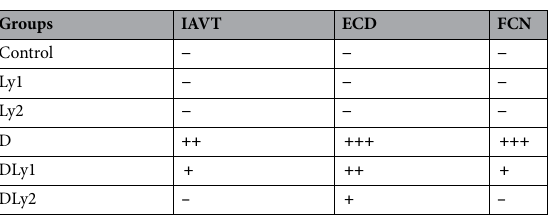
Table 4. Alleviating role of lycopene against meristematic cell injuries induced by dithane. Control: tap water, Ly1: 215 mg/L lycopene, Ly2: 430 mg/L lycopene, D: 500 mg/L dithane, DLy1: 500 mg/L dithane + 215